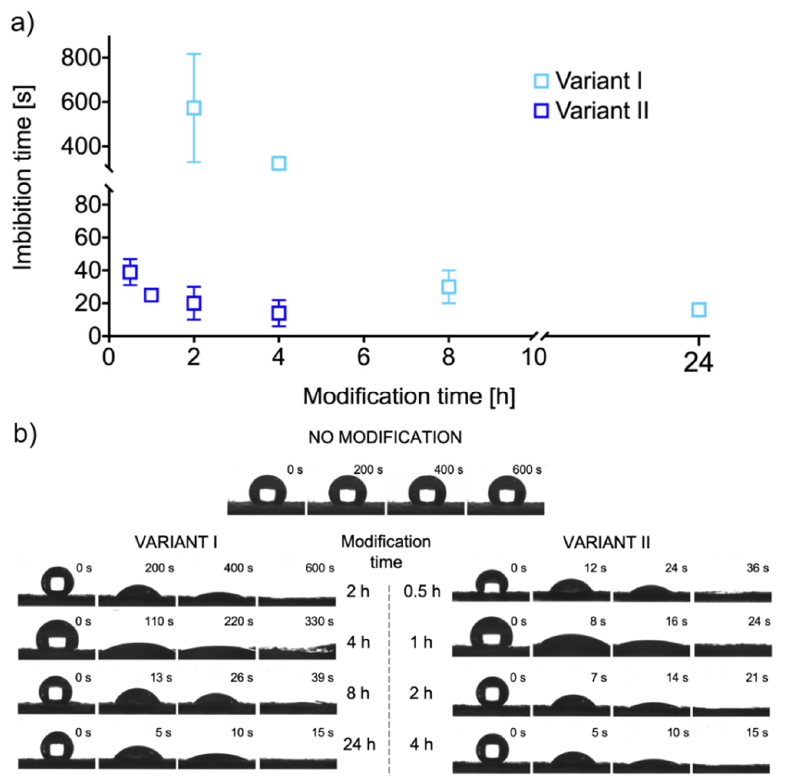
Figure 5. ( a ) Water droplet imbibition time as a function of PU nanofibrous materials modification time for both modification variants, ( b ) images of water droplet shape changes during the imbibition process on the surface of unmodified and modified PU nanofibrous materials.